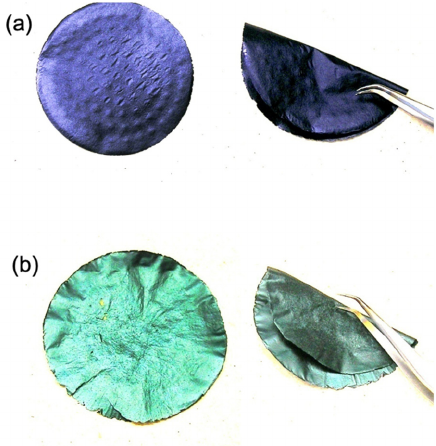
Figure 5. Photographs of chromatic nanocomposites with 50 wt% SWNTs. ( a ) PPEC8/SWNT and ( b ) PPEOC8/SWNT.